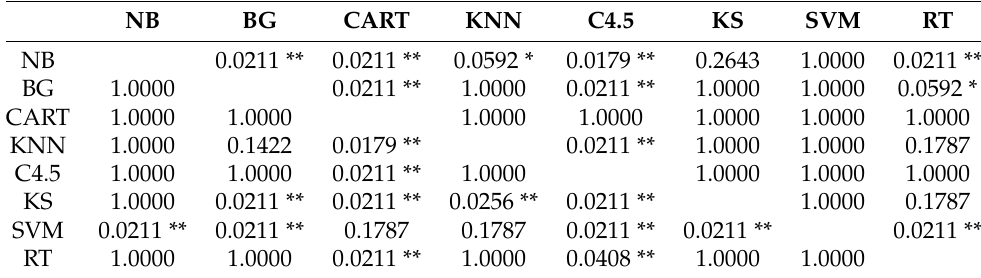
Table 9. Pairwise WSR test for accuracy of toddlers.